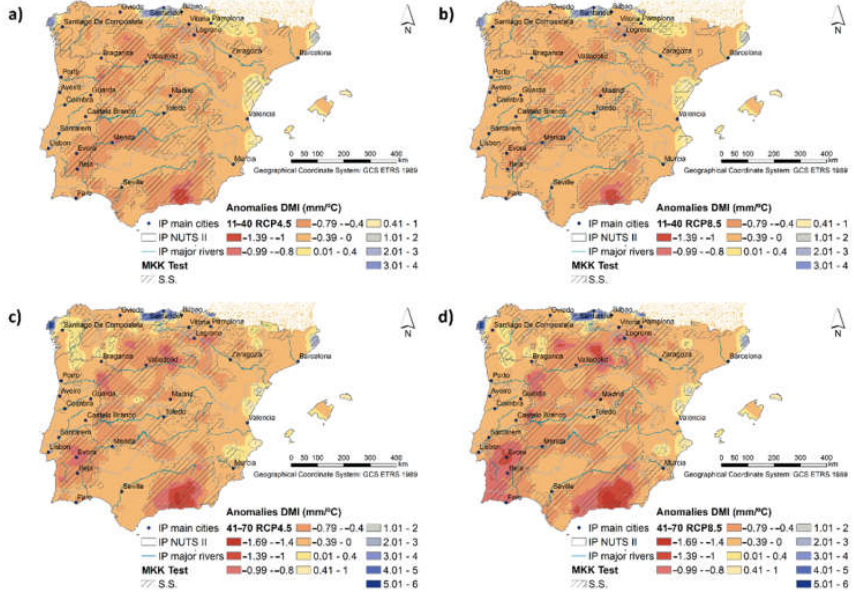
Figure 5. DMI anomalies (Mann–Whitney–Wilcoxon test at a 5% significance level) for the period ( a , b ) 2011–2040, ( c , d ) 2041–2070, with respect to the baseline climate (1961–1990), under RCP4.5 ( left ) and RCP8.5 ( right ).